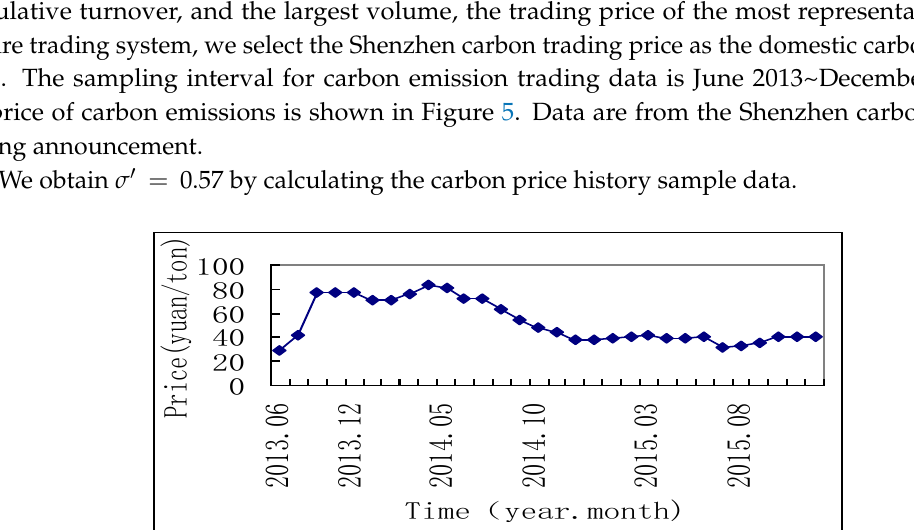
Figure 5. Historical transaction data of carbon emission.